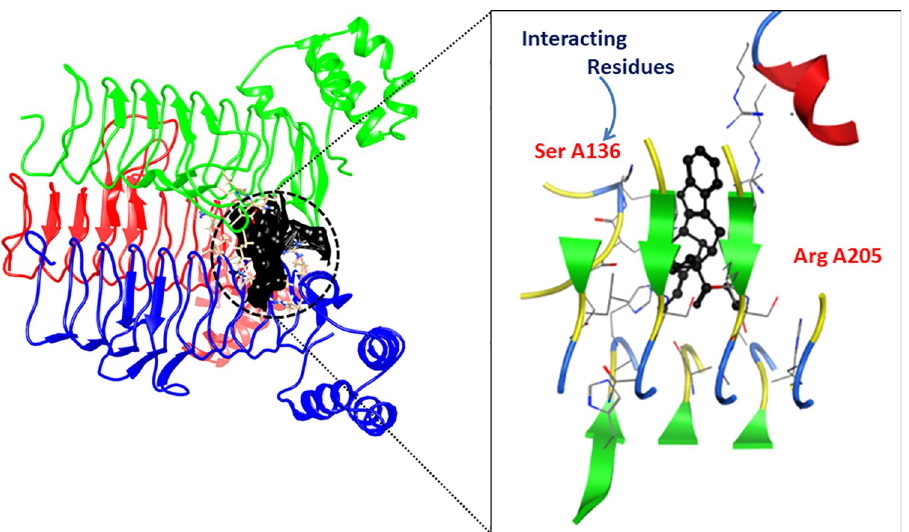
Fig 6. 2D and 3D interaction diagram of D-alanine-D-alanine ligase protein. The structure shows complex with Rhazin.